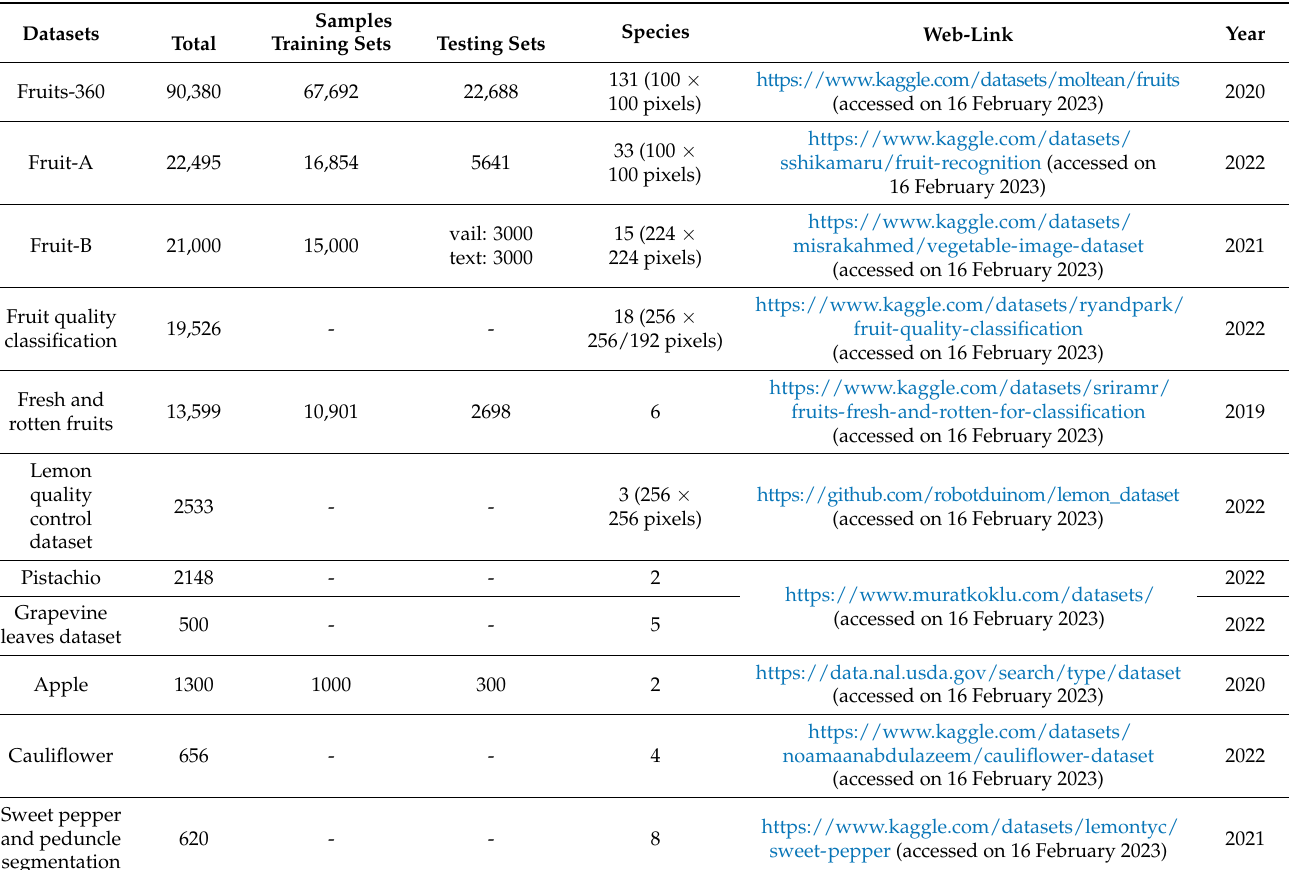
Table 4. Some frequently used image databases of crops: fruits and